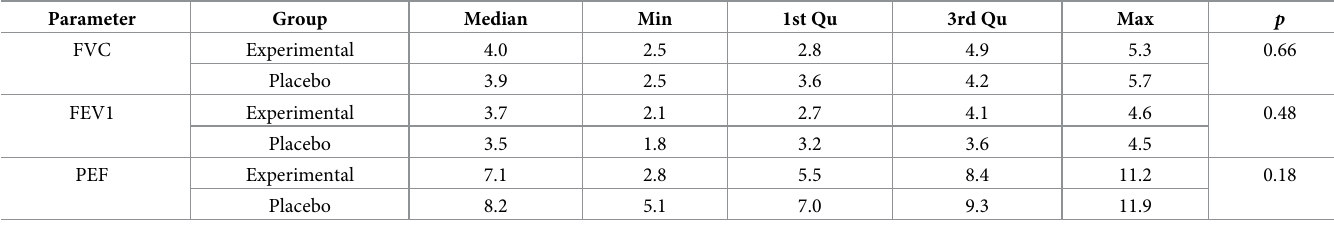
Table 1. The pulmonary parameters in experimental and placebo groups before the study. Parameter Group Median FVC Experimental Placebo FEV1 Experimental Placebo PEF Experimental Placebo